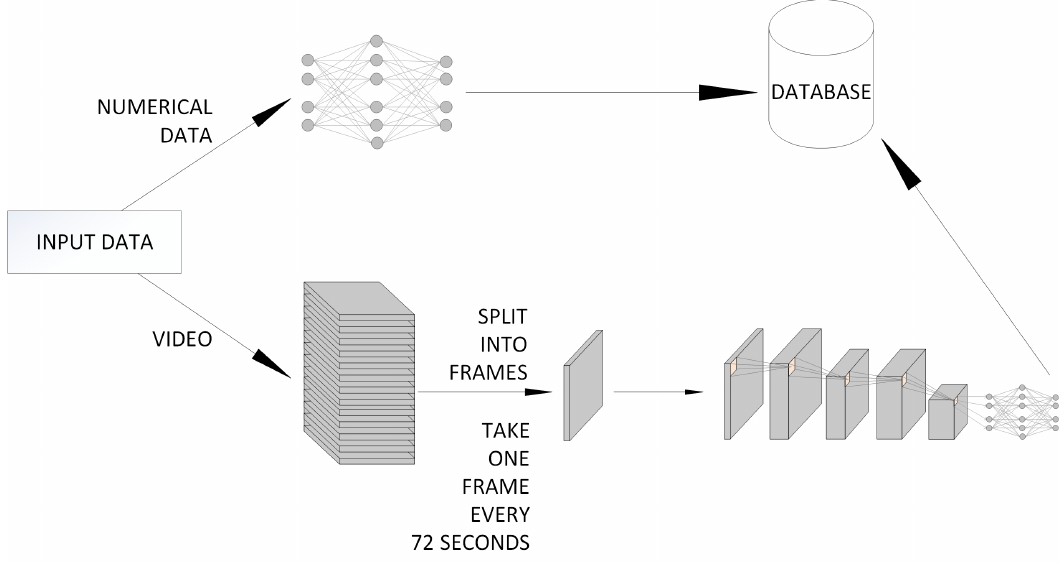
Figure 4. Graphical representation of the division of samples into